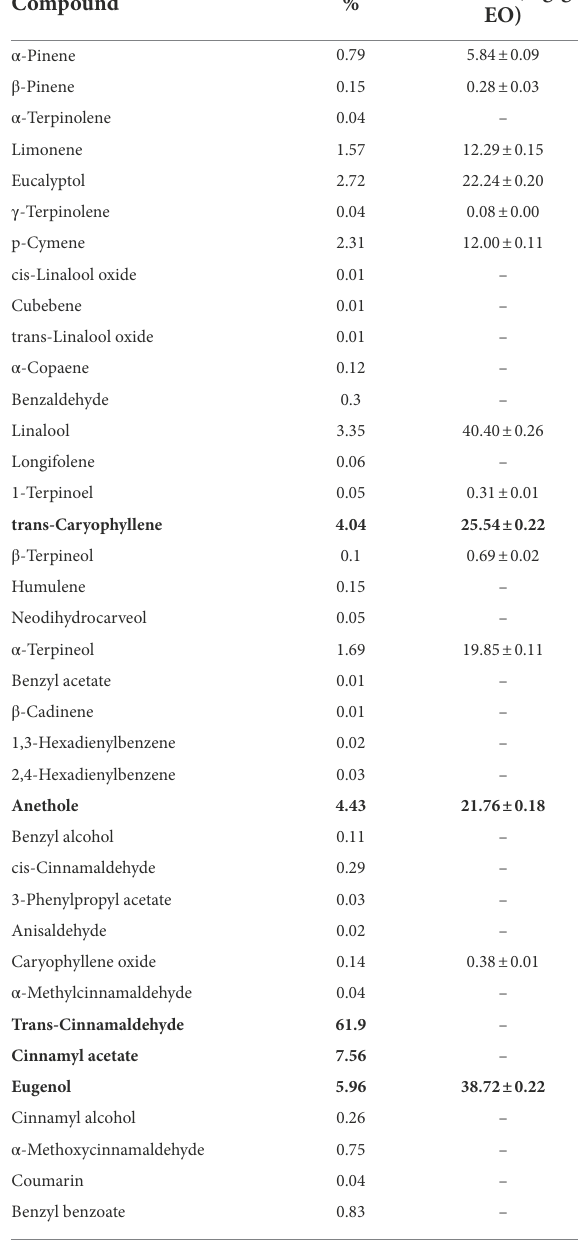
TABLE 2 Gas chromatography–mass spectrometry analysis of cinnamon essential oil.